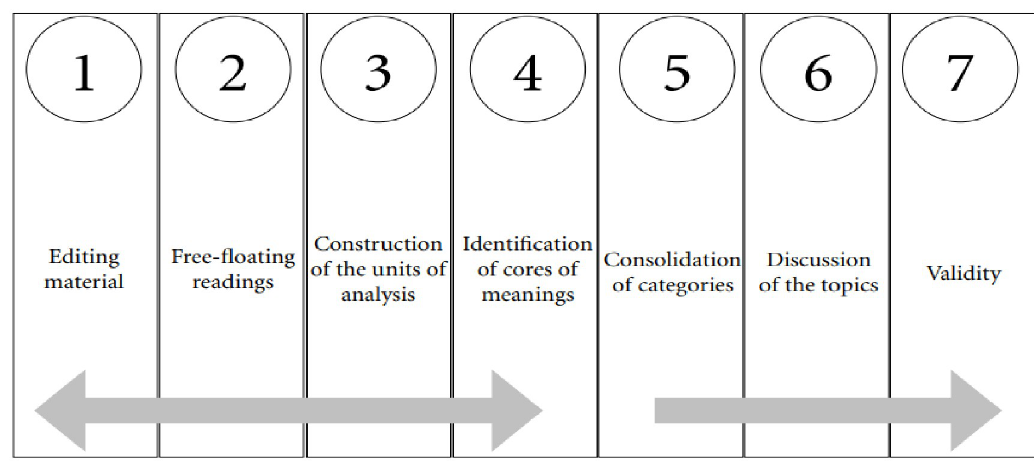
Fig 1. Flow chart of the Clinical-Qualitative Content